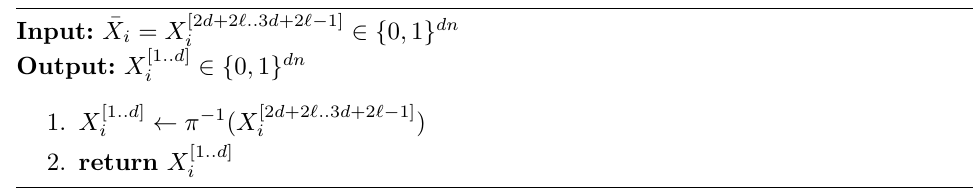
Algorithm 6: Procedure of Π for the i -th query ( δ